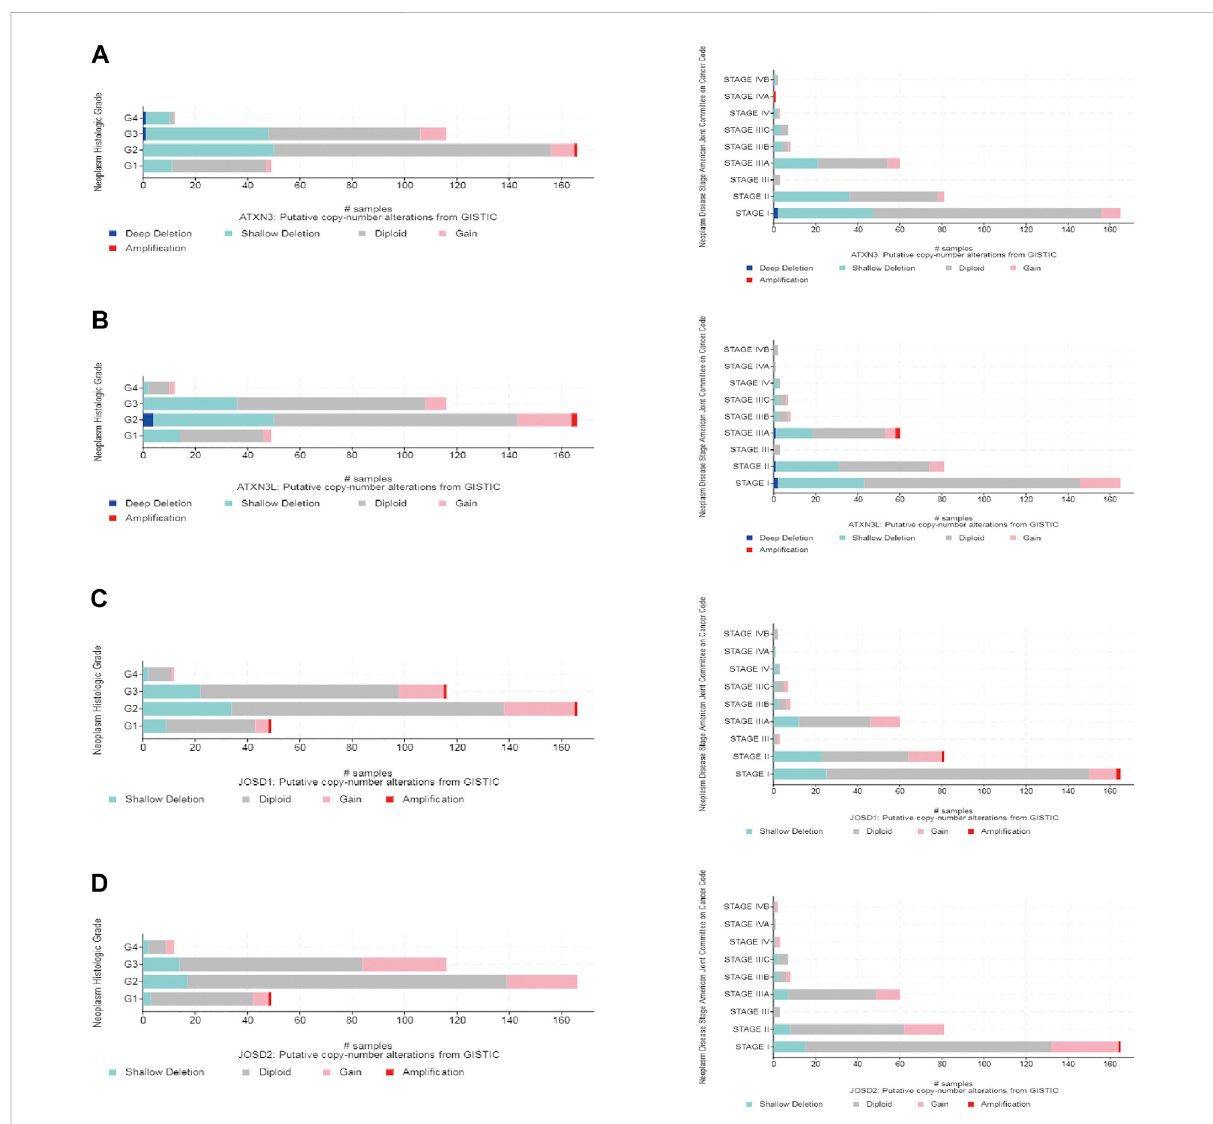
FIGURE 6 MJDsfamilymembersgenomicalterationsinHCC(cBioPortal) (A – D) CNVfrequenciesofMJDsfamilymembersweredistributedindifferentof stages and grades of